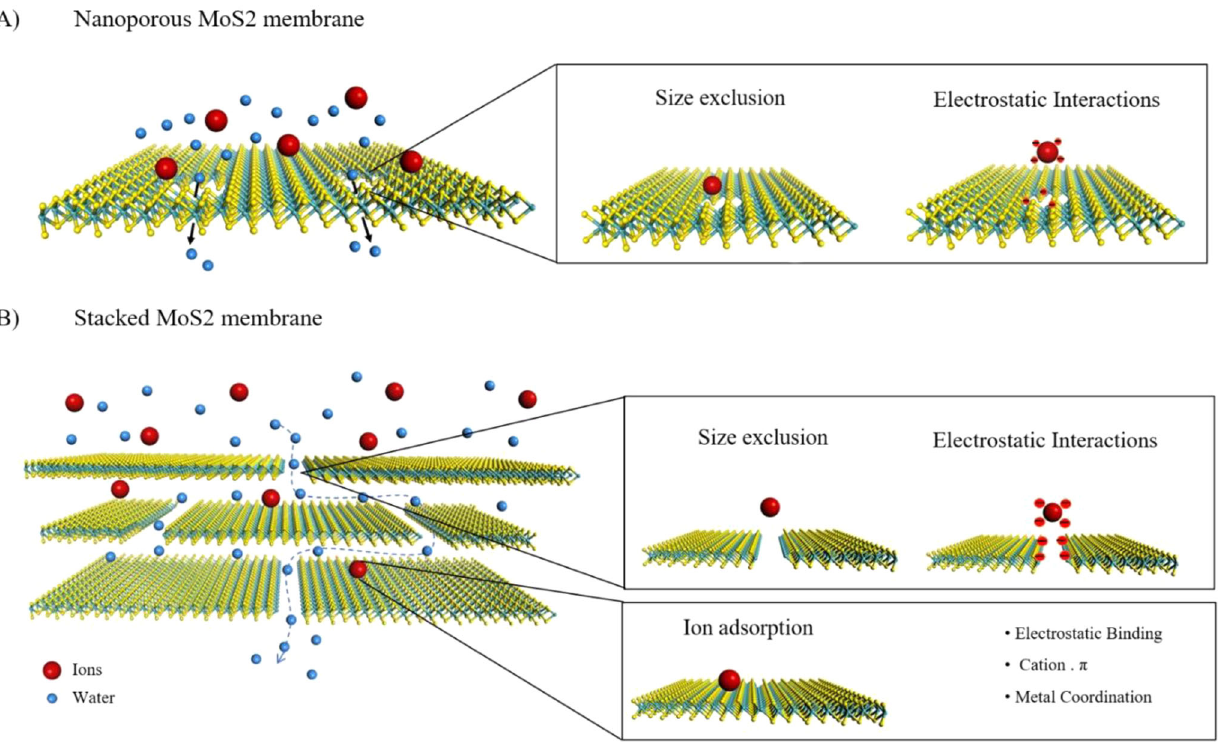
Fig. 3 2D Schematic illustration of a composite desalination membrane. a Nanoporous MoS 2 membrane ( b ) Stacked MoS 2 membrane. Reproduced with permission from Homaeigohar, S. et al. NPG Asia Mater 9, e427, 2017; licensed under a Creative Commons Attribution (CC BY) license 2 .